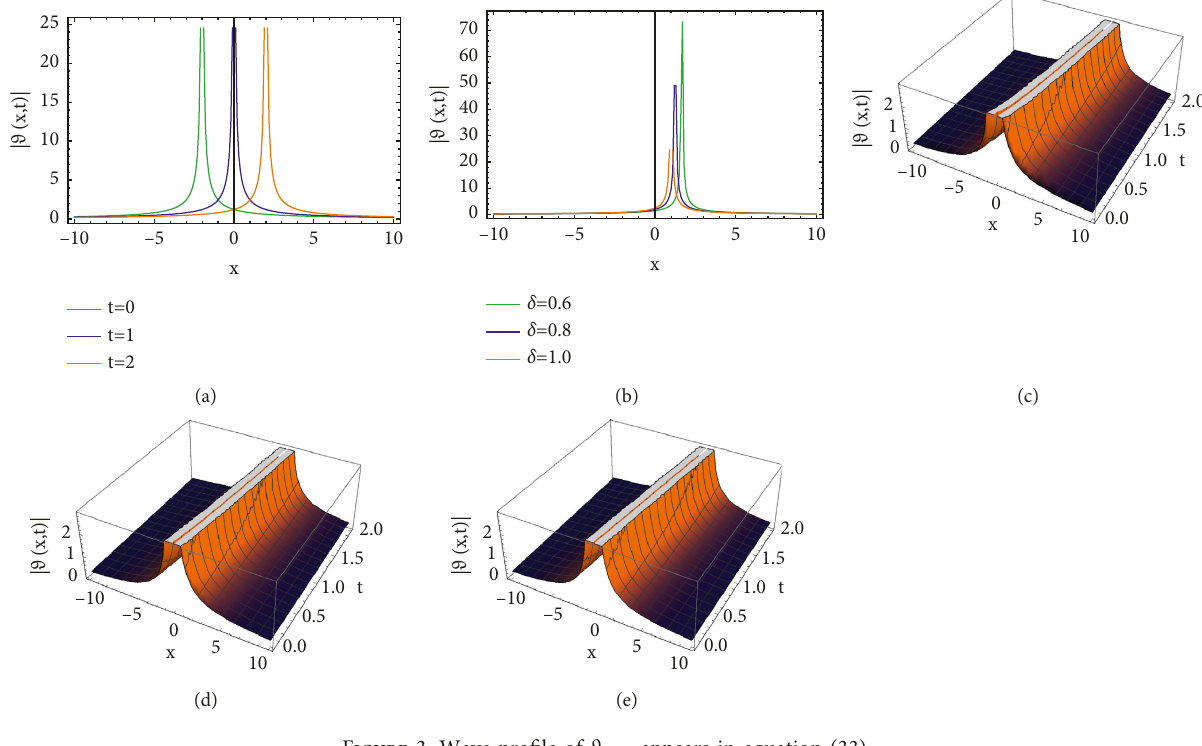
appears in equation x,t ( )